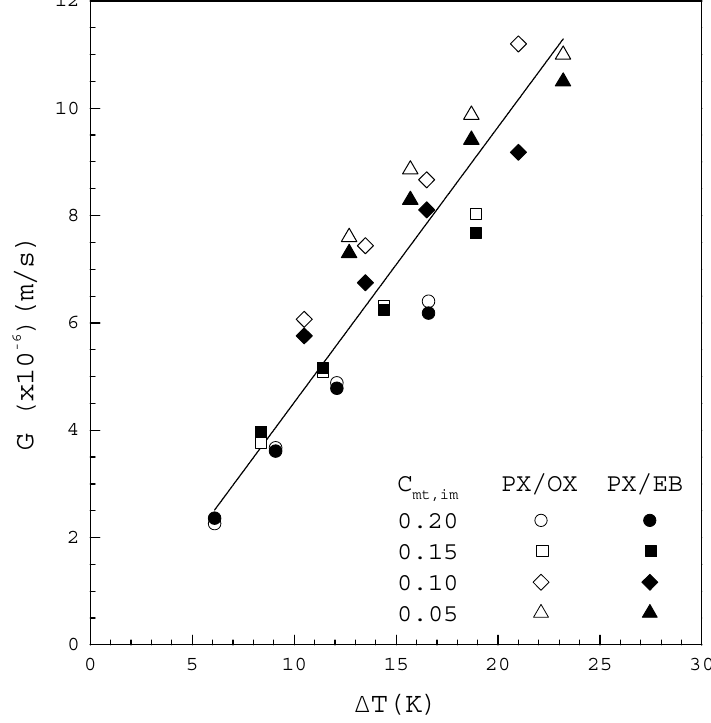
Figure 6. G plotted against ∆T for the PX/OX and PX/EB mixtures.